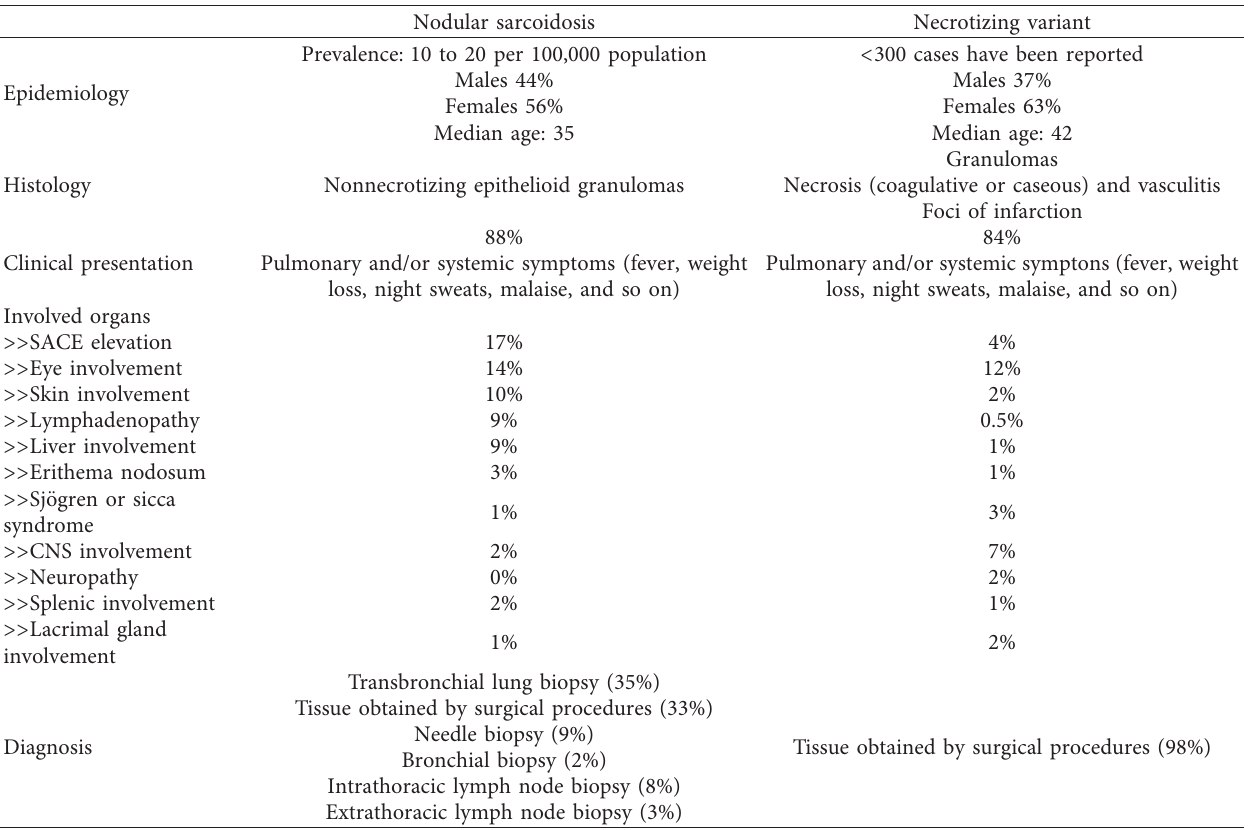
Table 2: Characteristics of classical variant (nodular sarcoidosis) and necrotizing variant (NGS) [2, 5].